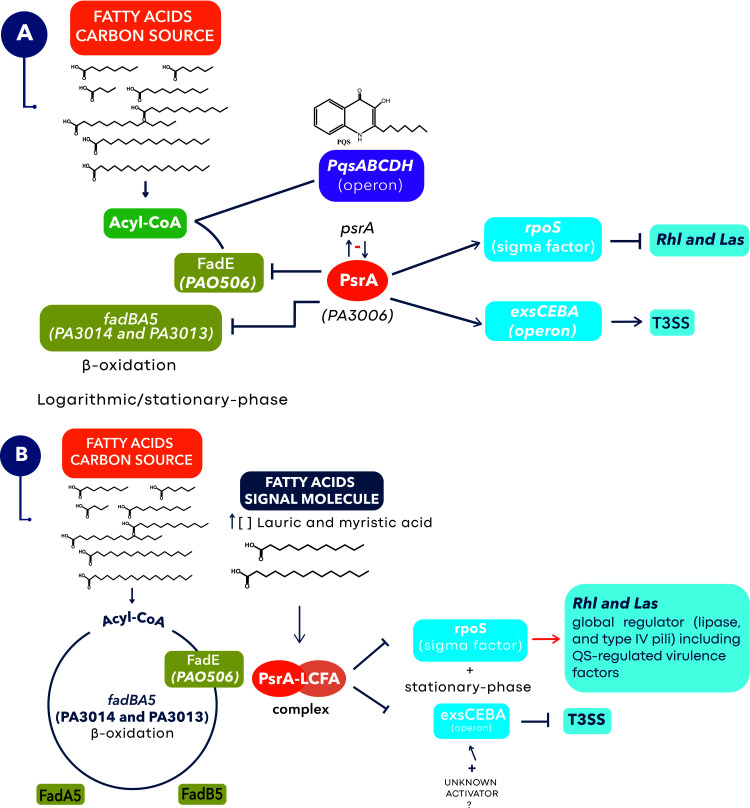
Proposed model for the role of lauric and myristic acids with PsrA at a higher level of regulation of pathogenicity in P. aeruginosa. (A) In late logarithmic growth phase PsrA binds to the promoters of fadBA5 and PA056, repressing β-oxidation through the fadBA5 pathway (Kojic et al., 2005; Son et al., 2007; Kang et al., 2008) and allowing the synthesis of PQS by blocking the expression of FadE (Wells et al., 2017). Similarly, PsrA maintains a negative self-regulation over its psrA promoter region (Kojic et al., 2002), but positively regulates rpoS transcription which prevents early activation of Rhl and Las QS systems (Pearson, 2002; Schuster et al., 2004). In this scenario, PsrA maintains a positive regulation over the exsCEBA operon needed to transcribe the T3SS genes (Kang et al., 2009) and for the secretion of ExoU, a lipase that will favor an increase in the concentration of lauric and myristic acids in the microenvironment of the host cell saponifiable lipids (Foulkes et al., 2019). (B) We suggest that an increase in the concentration of lauric and myristic acids (signal molecules) in the stationary phase will favor the formation of a PsrA-LCFA complex that removes the repression of the fadBA5, PA056, and rpoS promoter regions (Kang et al., 2008; Kang et al., 2009; Wells et al., 2017), activating β-oxidation through the fadBA5 pathway and the production of virulence factors regulated by the Rhl and Las QS systems (Pearson, 2002; Schuster et al., 2004). Meanwhile the PsrA-LCFA complex prevents the binding of PsrA with the promoter region of exsCEBA stopping the transcription of the T3SS genes (Kang et al., 2009). At this stage, some microenvironment or host factors (e.g., an unknown activator) could reactivate expression of the T3SS.